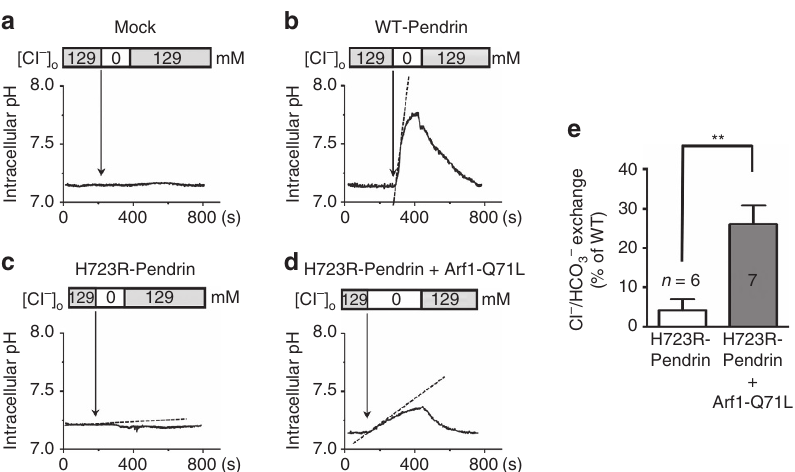
Figure 2 | Rescue of anion exchange activity of H723R-pendrin by Arf1-Q71L. The Cl (cid:2) /HCO 3 (cid:2) exchange activity was measured by recording pH i as detailed in Methods. A clone of HEK 293 cells that exhibited minimal intrinsic anion (Cl (cid:2) /HCO 3 (cid:2) ) exchange activity ( a ) was transfected with the indicated plasmids ( b – d ) and then anion exchange activity was analysed. The quantitation of multiple experiments is depicted in e . Blockade of ER-to-Golgi trafficking by Arf1-Q71L significantly increased Cl (cid:2) /HCO 3 (cid:2) exchange activity in cells expressing H723R-pendrin. ** P o 0.01 by unpaired Student’s t -test, the number of replicates ( n ) is presented in each Cl (cid:2) /HCO 3 (cid:2) exchange activity was examined in a clone of HEK 293 cells that has minimal intrinsic Cl (cid:2) /HCO 3 (cid:2) exchange activity (Fig. 2a–e). The Cl (cid:2) /HCO 3 (cid:2) exchange activity was measured in cells attached to coverslips by recording pH i in response to [Cl (cid:2) ] o changes of the perfusate. Strong Cl (cid:2) /HCO 3 (cid:2) exchange activity was elicited by transfection with WT-pendrin (0.230 ± 0.029 D pH unit min (cid:2) 1 , n ¼ 13), but not H723R-pendrin (0.010 ± 0.006 D pH unit min (cid:2) 1 , n ¼ 6). Notably, blockade of the ER-to-Golgi transport by Arf1-Q71L significantly increased the H723R-pendrin-mediated Cl (cid:2) /HCO 3 (cid:2) exchange activity to 0.060 ± 0.011 D pH unit min (cid:2) 1 ( n ¼ 7, P o 0.01), which corresponded to 26% of the WT-pendrin activity. Taken together, these results indicate that ER-to-Golgi